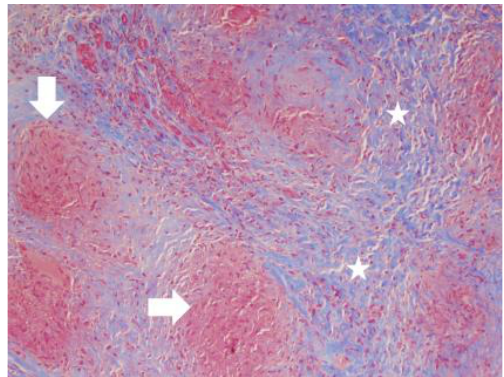
FIGURE 3 . Masson stain of the liver biopsy showing areas of granulomas (arrows, in red-stained area) surrounded by fibrosis (stars, in blue-stained